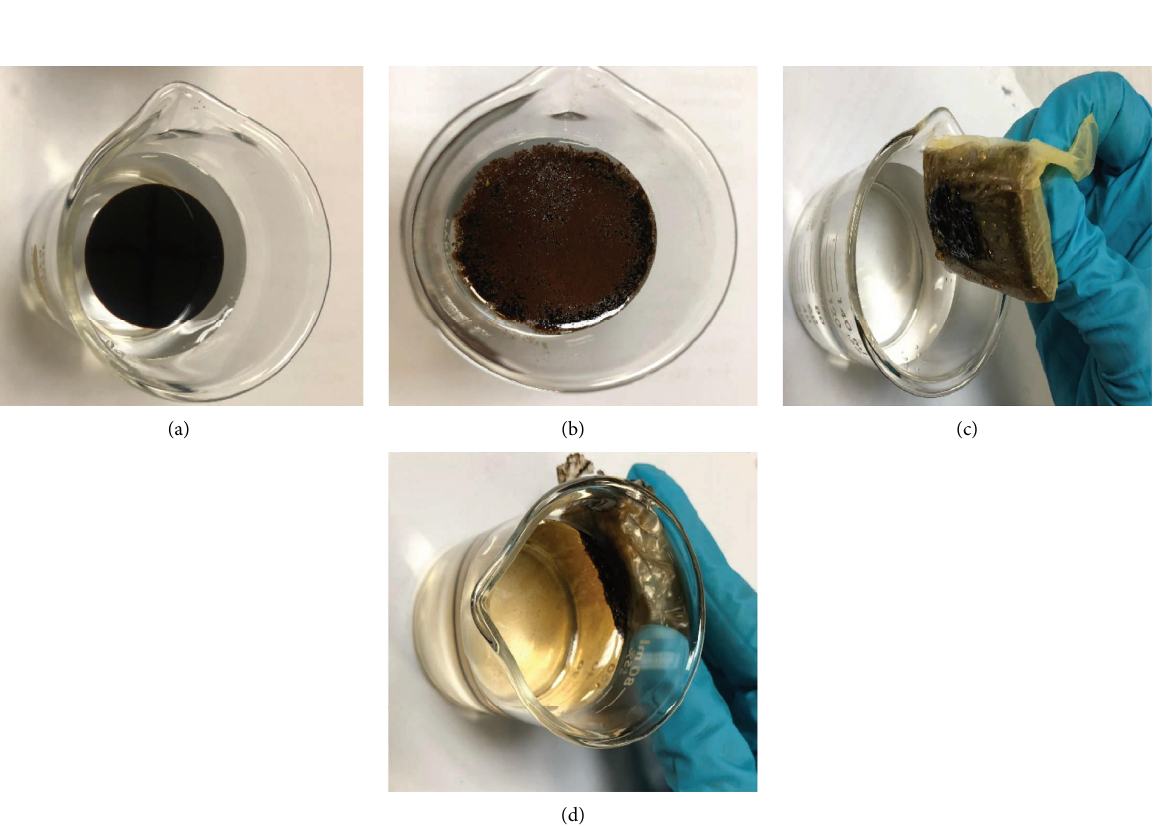
Figure 10: Optical images of (a) oil spilled over seawater, (b) dispersed GO-MNPs over the crude oil at MNP: crude oil ratio of 1: 2, (c) oil removal using method A, and (d) oil removal using method